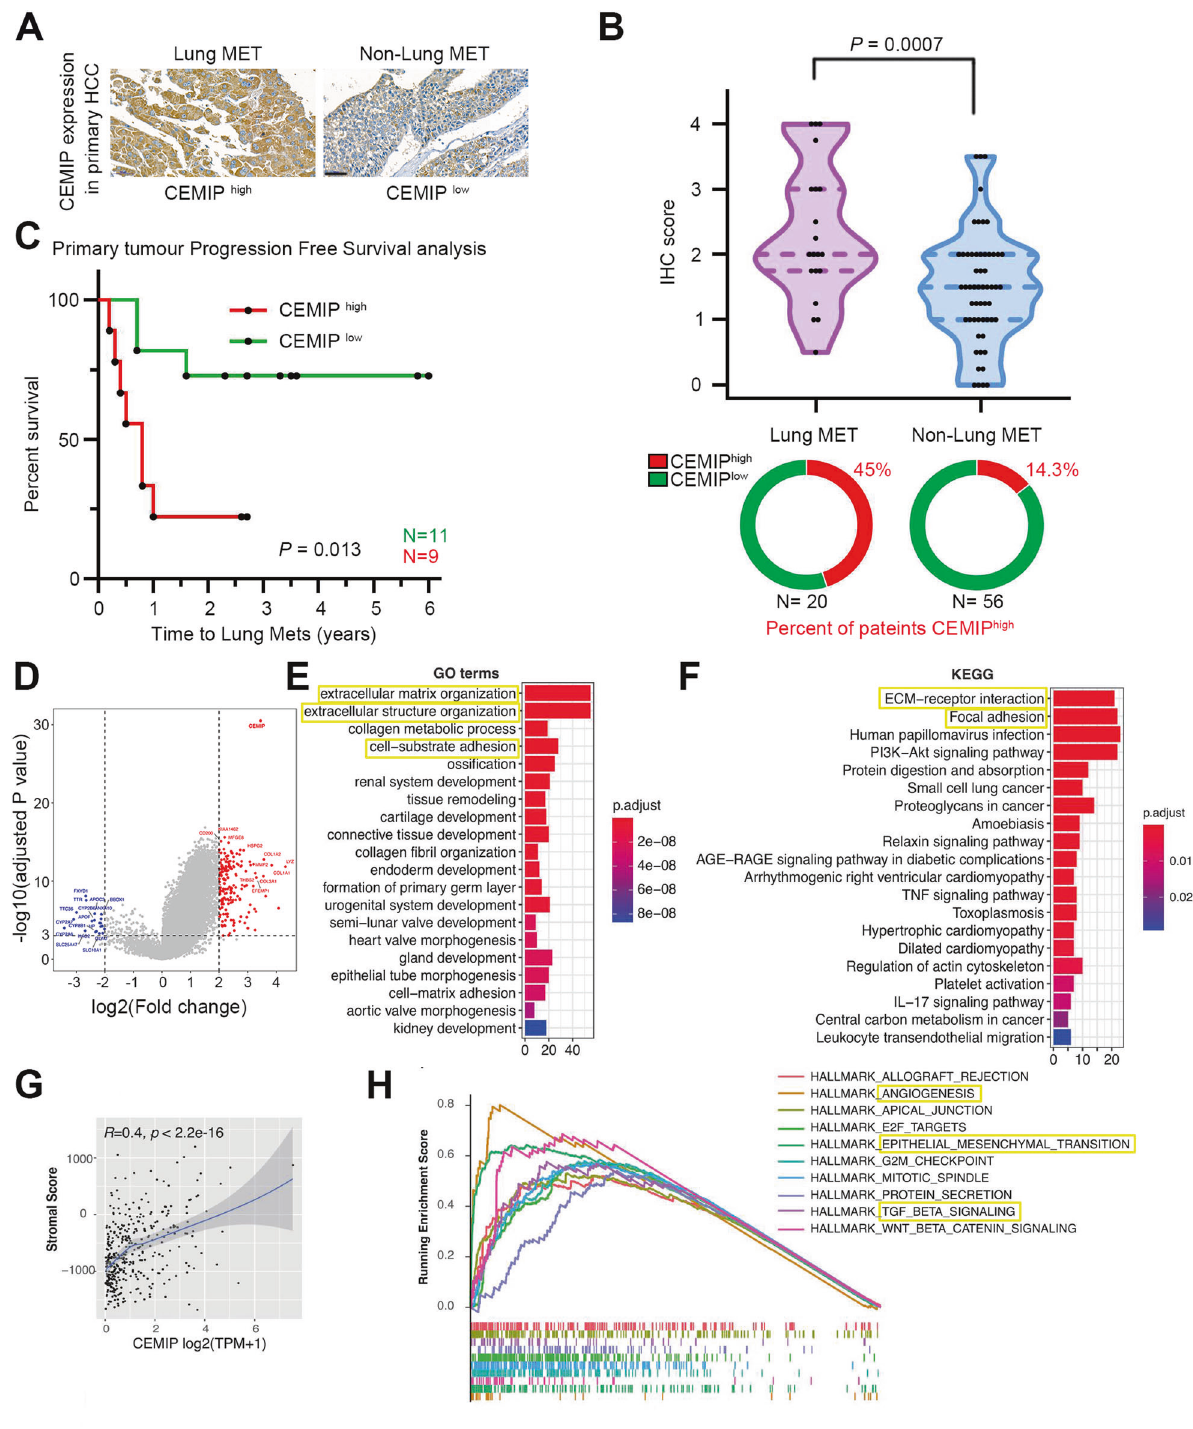
Fig. 1 The CEMIP expression level is associated with lung metastatic progression in liver cancer. A Representative immunohistochemistry images illustrating CEMIP expression levels in patients with or without lung metastasis. Scale bars, 50 μ m. B CEMIP immunohistochemistry staining scores in primary HCC tissues obtained from patients with or without lung metastasis. The CEMIP expression level was signi fi cantly higher in the pulmonary metastatic group than in the non-metastatic group ( P < 0.05). C Kaplan – Meier curves depicting the time to fi rst lung metastasis (from diagnosis time) based on whether CEMIP expression levels in the primary tumor were low (green) or high (red). D Volcano plot showing the differentially expressed genes (DEGs) between samples exhibiting high (top 10%) and low (bottom 10%) levels of CEMIP expression in the TCGA cohort. E , F GO and KEGG enrichment analyses of signi fi cant DEGs (Log2|fold change | >2 and P < 0.001). G Scatter plots depicting the Spearman correlations for CEMIP expression and stromal score. H Gene set enrichment analysis (GSEA) plot showing the enrichment of tumor hallmarks in tumors exhibiting high levels of CEMIP expression (top 10%), in comparison to that in tumors exhibiting low levels of CEMIP expression (bottom 10%).